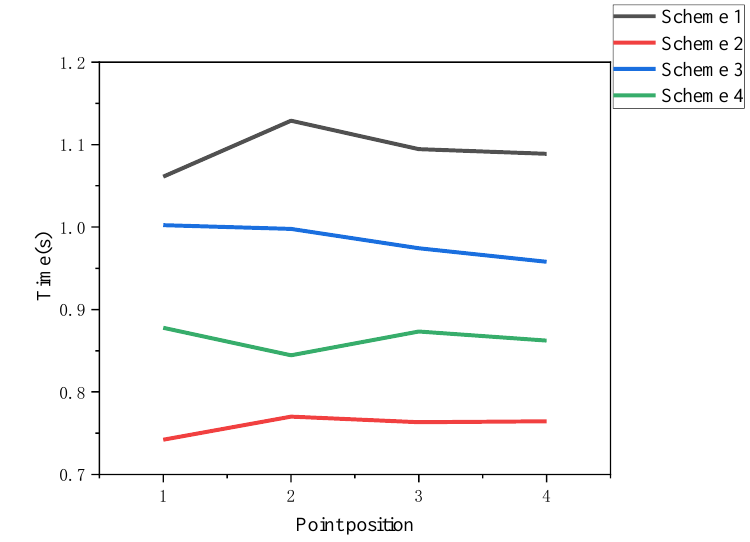
Figure 19. Mean value of different schemes at each point.